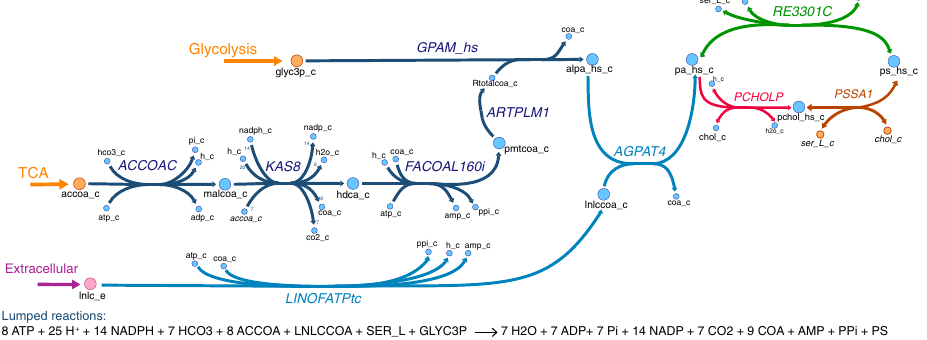
Fig. 4 Biosynthesis of biomass building blocks. a Size of lumped reactions for Recon 2 and Recon 3D, and the corresponding number of alternatives to synthesize the BBBs that cannot be produced by the core nor uptaken from the extracellular medium. b , c Subnetwork for the synthesis of phosphatidylserine. Orange represents the metabolites from the core network. Blue represents the metabolites from the subnetwork for phosphatidylserine synthesis. Pink represents the extracellular metabolites. Phosphatidylserine synthesis starts from the core metabolites glycerol 3-phosphate (glyc3p_c), from glycolysis, and acetyl CoA (accoa_c), from TCA. In the fi rst reaction, acetyl CoA is transformed into malonyl CoA (maloca_c). The next reaction (KAS8) represents the synthesis of palmitate (hdca_c) in the elongation cycle 74 . A CoA molecule is attached to palmitate to form palmitoyl CoA (pmtcoa_c), from which the two generic fatty acids are derived. These two generic fatty acids are attached to glycerol 3-phosphate to form lysophosphatidic acid (alpa_hs_c) and phosphatidic acid (pa_hs_c). Finally, serine (ser_L_c) is attached to phosphatidic acid to form phosphatidylserine (ps_hs_c). b Subnetwork from Recon 2 and corresponding lumped reaction. c The four alternative subnetworks of minimum size from Recon 3D. Phosphatidic acid can be produced with two generic fatty acids or with one generic fatty acid and the essential fatty acid linoleic acid (lnlc_e) (light blue reactions). Phosphatidylserine can be directly produced from phosphatidic acid by attaching serine (green reaction) or through the formation of phosphatidylcholine (red reaction) and then changing choline (chol_c) for serine (orange